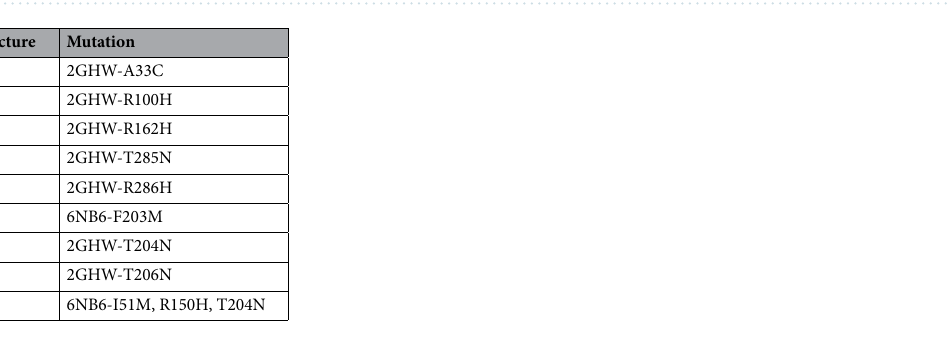
Table 1. The final neutralizing candidates obtained through screening with ML model, MD simulation for stability and bioinformatics. The detailed list of sequences is available in the “Supporting Information”.